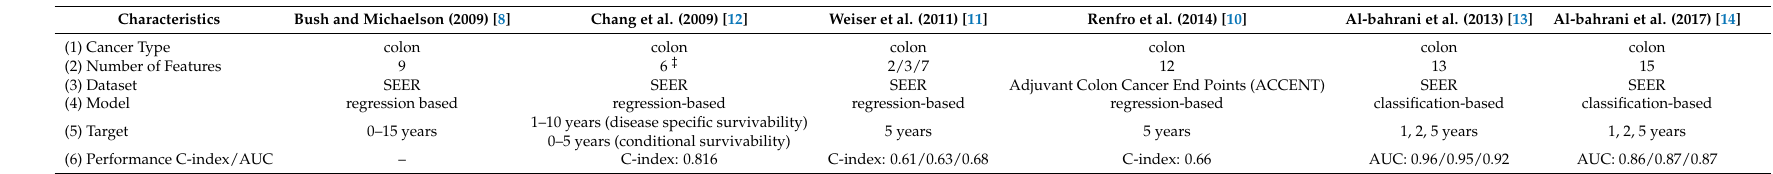
Table 1. Characteristics of models for colon and rectal cancer survivability prediction.